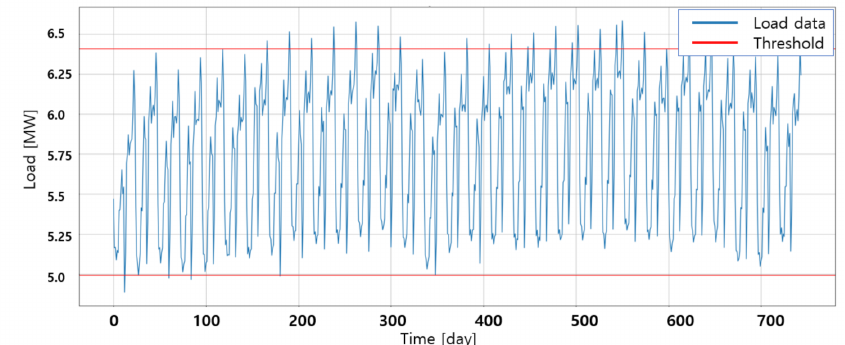
Figure 4. Example of the daily load patterns without the daily pattern procedure.